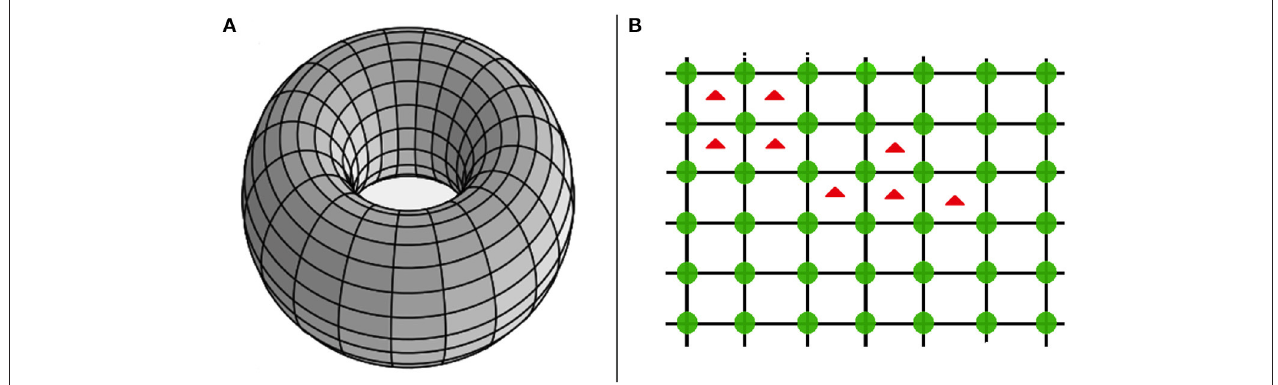
FIGURE 1 | Pictorial representation of the interaction topology. In particular, cooperative cells are arranged over a toroid (i.e., A ), while bacteria occupy inner squares. Notably, ( B ) shows a fragment of the toroid, with green circles representing cooperative cells, and red triangles representing bacteria inside infected